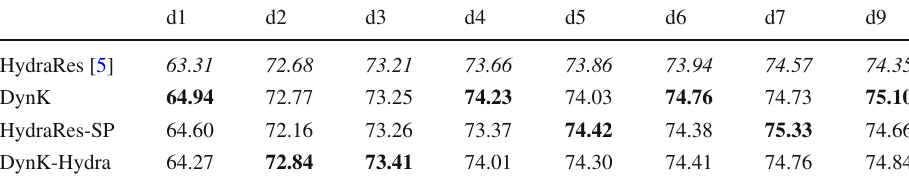
Table 4 Accuracy for multiple architectures depth on CIFAR-100 data set